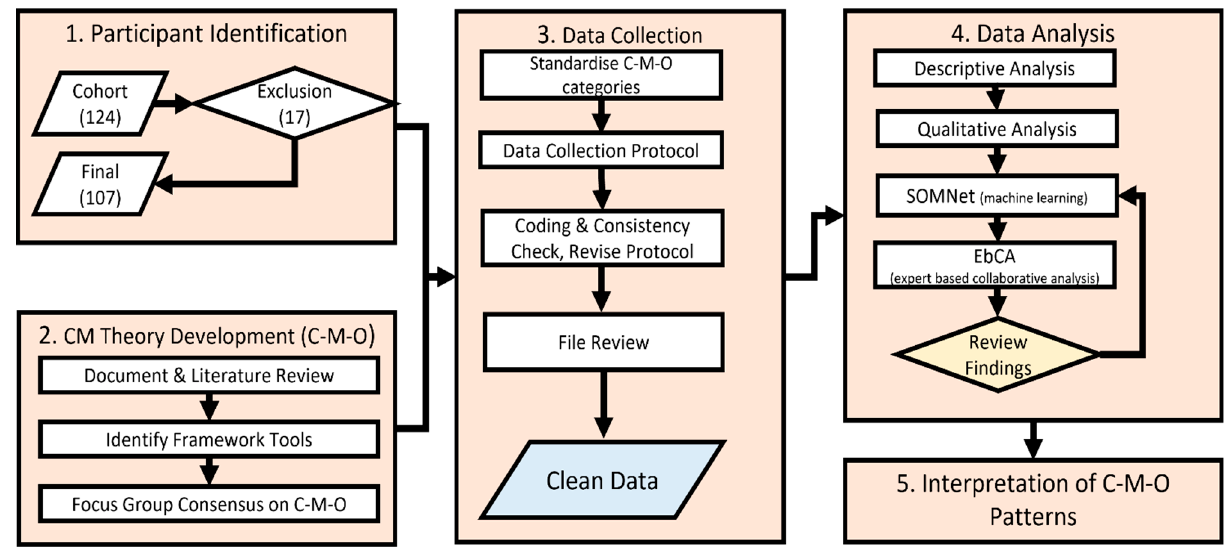
Figure 1. Flow chart of study method .